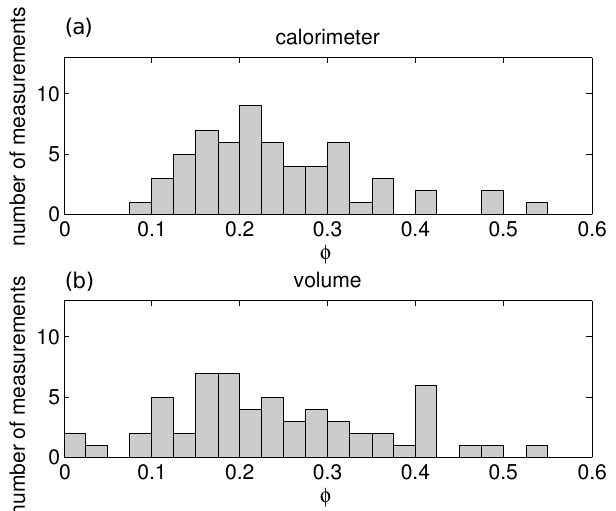
Fig. 6. Sketch of a disc in a cuboid: x 1 = 2 r y 1 = 2 r cos α , y 2 = 2 r sin α and z = 2 r H